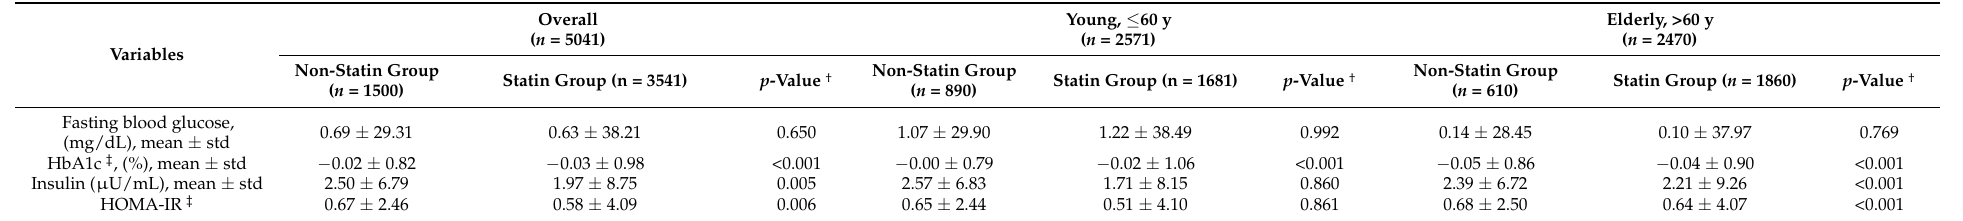
Table 2. Changes in serum levels of glucose, HbA1c, insulin and HOMA-IR among non-statin users and statin users before propensity score matching—overall and in young and elderly cohorts.